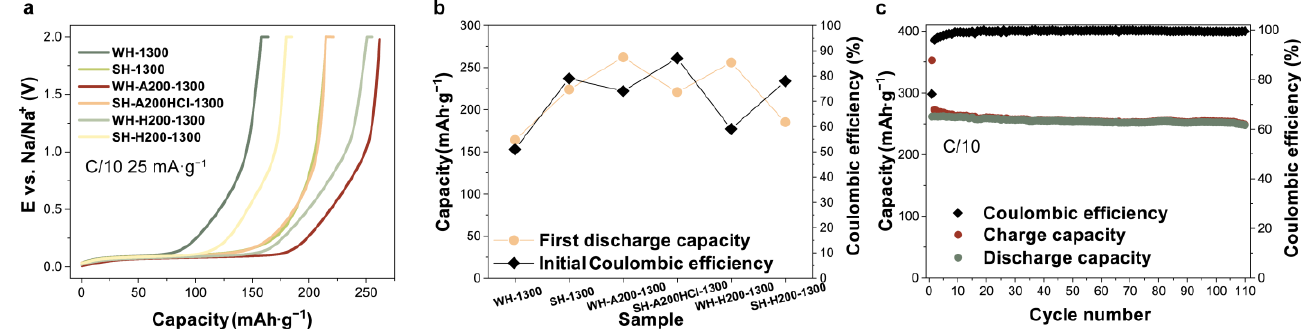
Figure 4. First discharge curves ( a ) and discharge capacity in the first cycle and initial Coulombic efficiency ( b ) of HC electrodes at current density of 0.1 C (25 mA g −1 ); charge, discharge capacity and Coulombic efficiency for 100 cycles at 0.1 C (25 mA g −1 ) of WH-A200-1300 ( c